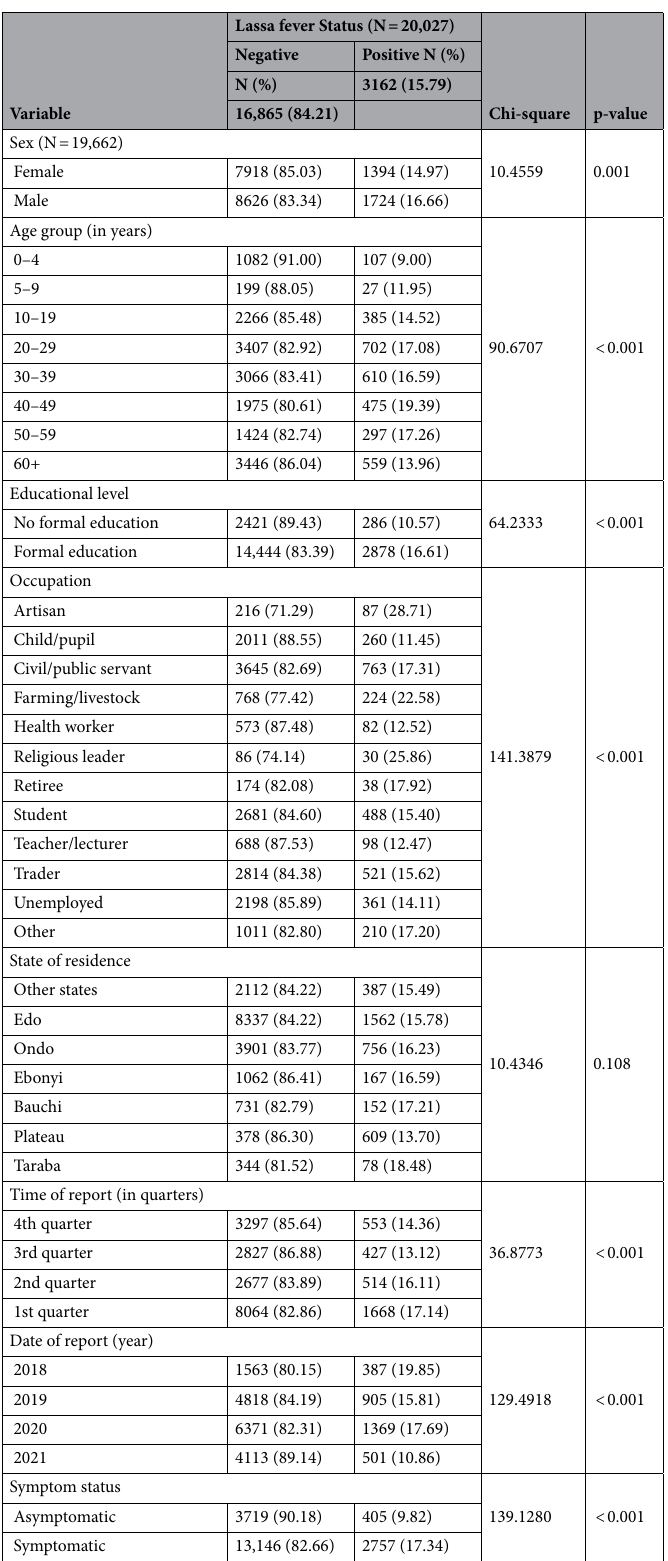
Table 1. Association between sociodemographic factors and Case Positivity among Lassa fever suspected cases in Nigeria from 2018 to